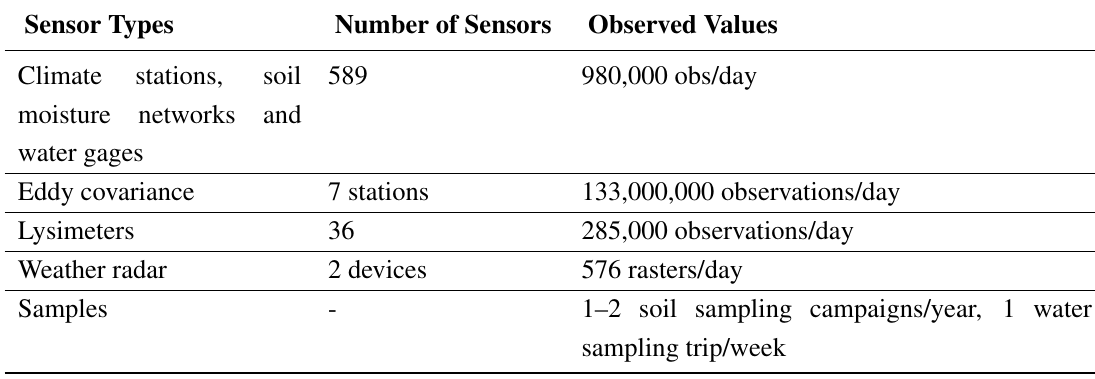
Table 2. Sensors deployed at the Eifel/Lower Rhine